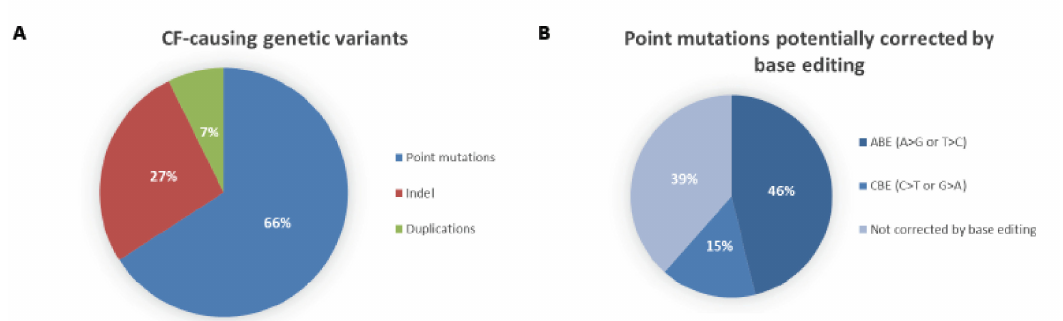
Figure 2. Distribution of cystic fibrosis-causing variants. ( A ) According to the Variant List History from 11 March 2019 available on the CFTR2 database (https: // www.cftr2.org / ), there are 346 CF-causing